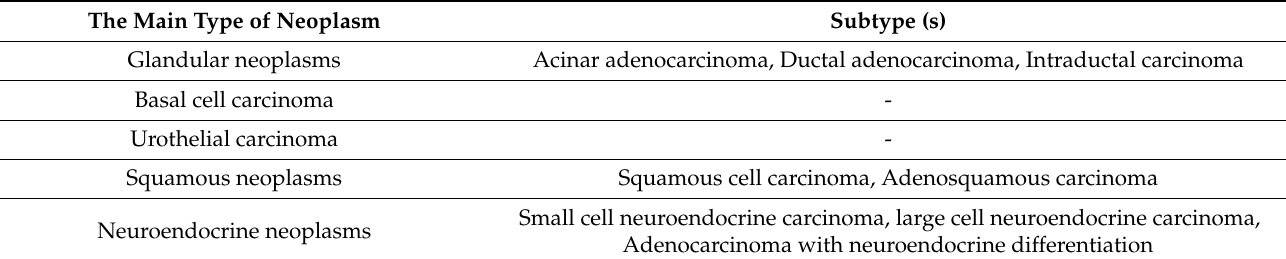
Table 1. General classification of prostatic carcinoma. Adapted from Refs.